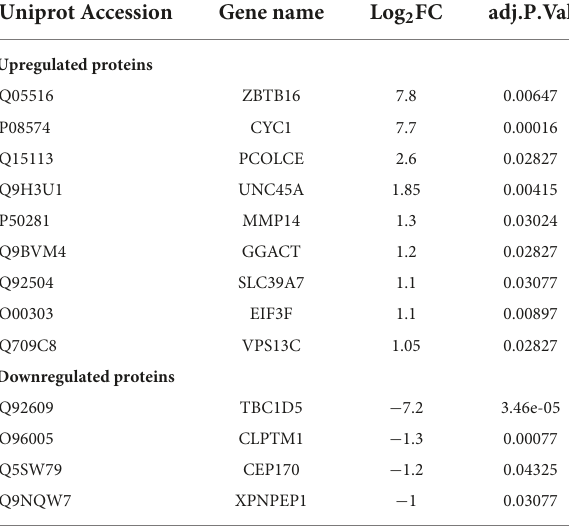
TABLE 1 Differentially expressed proteins between human valve interstitial cells (VIC) in osteogenic conditions and VIC in osteogenic conditions with ZBTB16